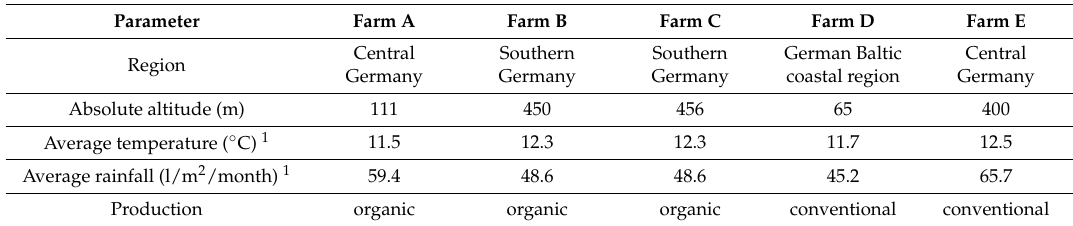
Table 1. Characteristics of the